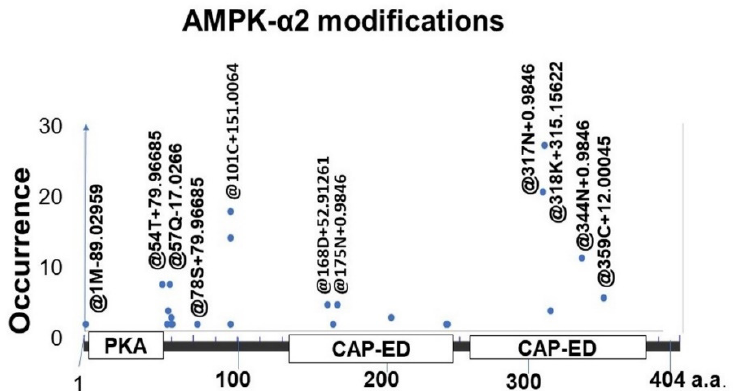
Figure 4. Proteomic analysis using liquid chromatography–tandem mass spectrometry (LC-MS/MS) implies post-translational modifications of AMPK- α 2 protein at phosphorylation sites, including 54T + 79.967 and 78S + 79.967 near the C-terminal region of the PKA domain. Other modifications include @168D + 52.913 and @318K + 315.156 in the first and second CAP-ED motif, respectively. The modification types and positions are assigned with @ + position + amino acid + delta mass. This figure is taken from our previous publication [41].